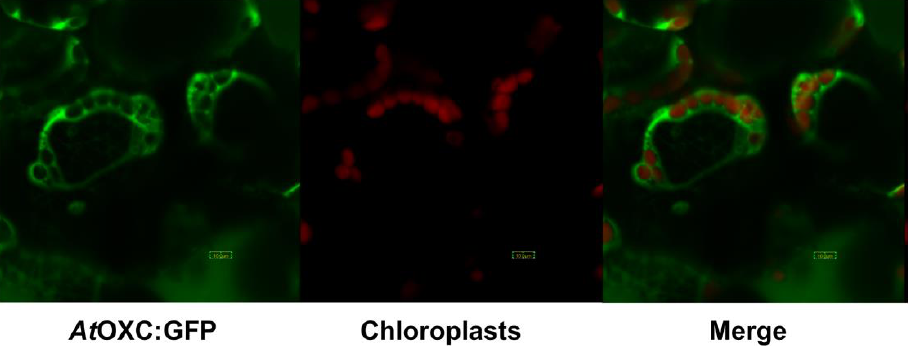
Figure 6. Subcellular localization of AtOXC-GFP. AtOXC-GFP expression in leaves of A. thaliana ( left ), chloroplast autofluorescence ( middle ), and merge of AtOXC-GFP and autofluorescence ( right ). Bar = 10 µm. Table 1. T-DNA transmission analysis of atoxc-2